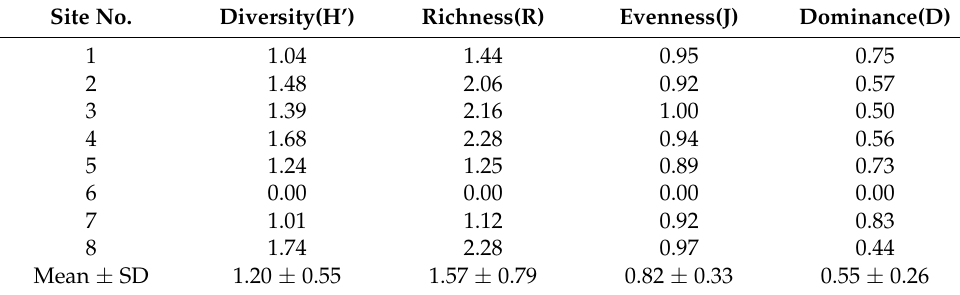
Table 5. Ecological indices of macrobenthic information collected from the tidal flat of Yubu Island in the western coastal area of South